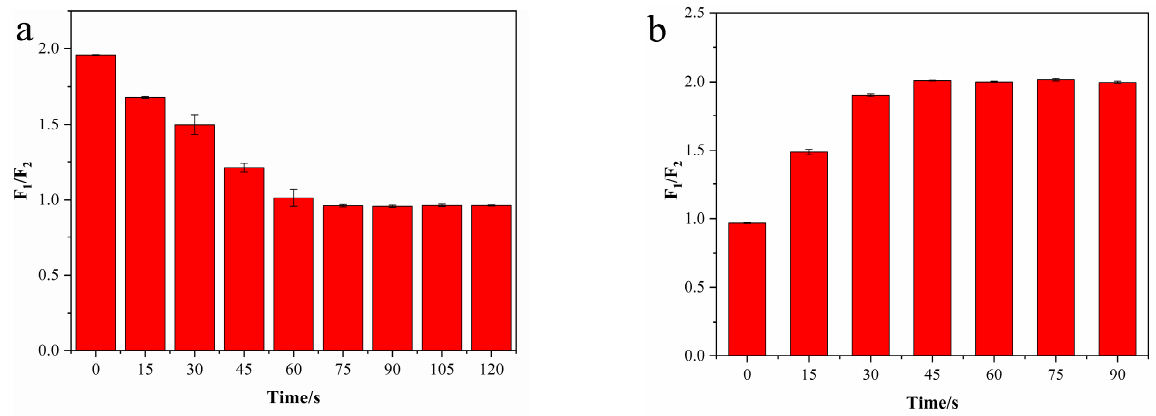
Figure 10. ( a ) The response time to Arg of our N-CD/calcein sensor; ( b ) the response time to AP of N-CD/calcein/Arg complex system.